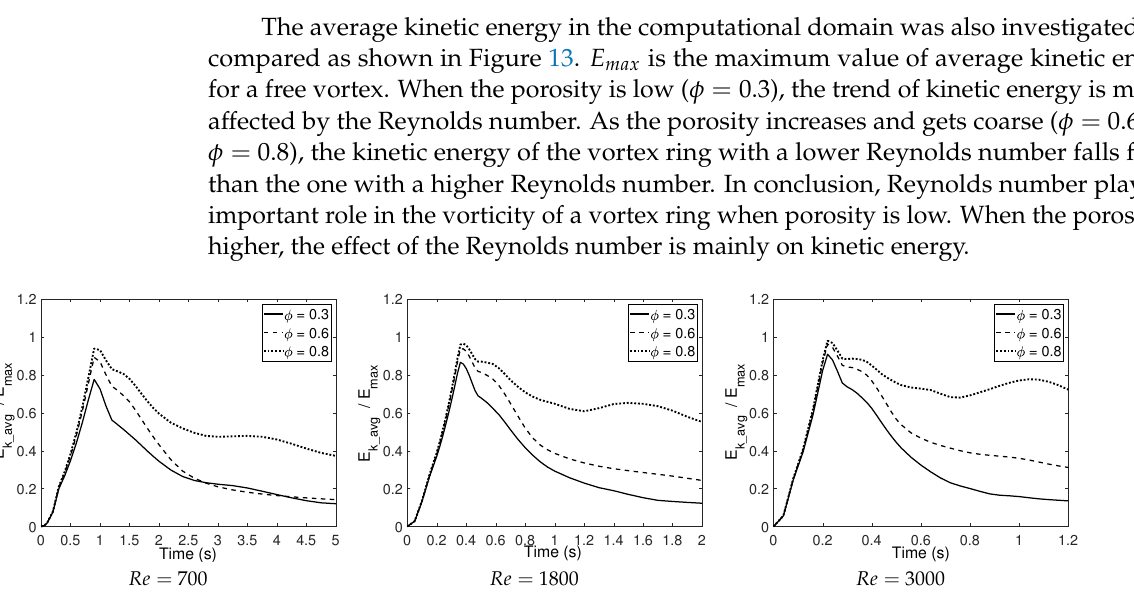
Figure 13. Average kinetic energy in computational domain within t ∗ =